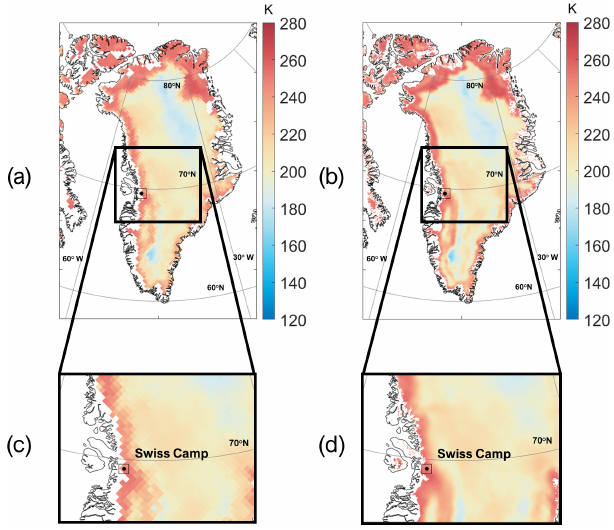
Figure 1. Maps of PMW T b at 37GHz, horizontal polarization, ac- quired over Greenland on 16 July 2001 with the (a) coarse (25km) and (b) enhanced (3.125km) resolution products. Panels (c) and (d) refer to the area highlighted in the square in panels (a) and (b)